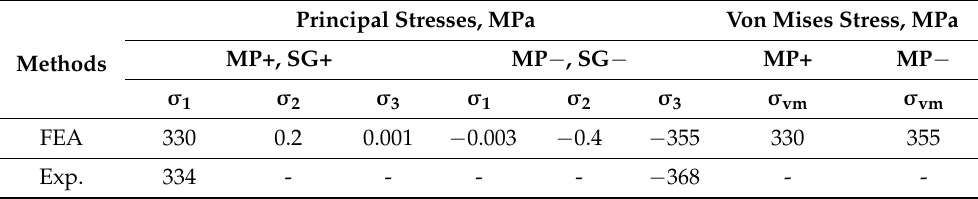
Table 4. Maximum values of principal and von Mises stresses at the measuring